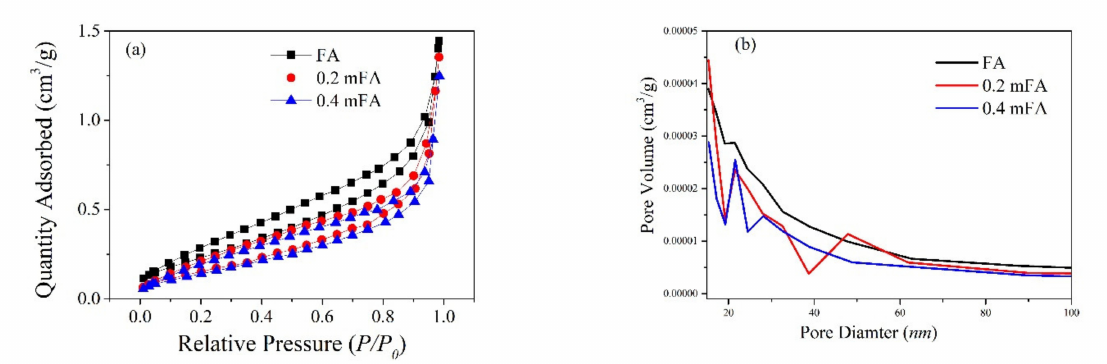
Figure 5. ( a ) Nitrogen isothermal adsorption and desorption profiles and ( b ) pore size distribution.